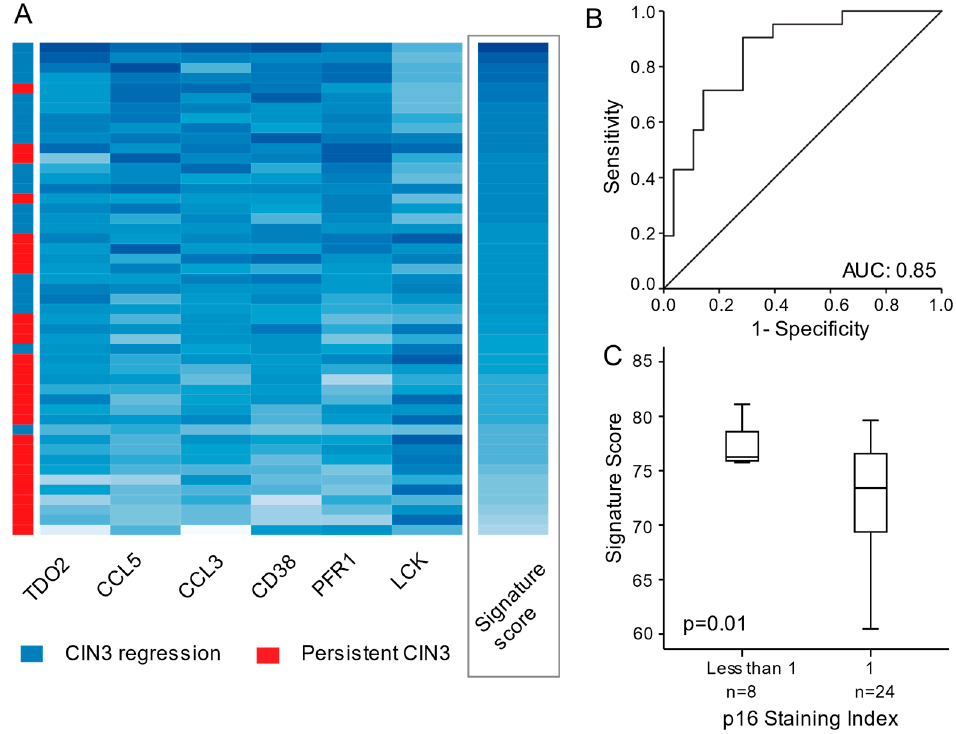
Figure 2. ( A ) Heatmap illustrating signature score for each gene (column) within each individual patient (row) with risk group defined by red or blue color as indicated. Increasing darker blue color represents increasing gene expression level. In the last column, increasing darker blue color illustrates increasing signature score for each patient sorted by highest to lowest signature score. ( B ) Receiver operating (ROC) curve reflecting the sensitivity, specificity, and area under the curve (AUC) for the gene signature to predict risk group within the 49 precursor lesions. ( C ) Immunohistochemistry p16 Staining Index compared to the signature